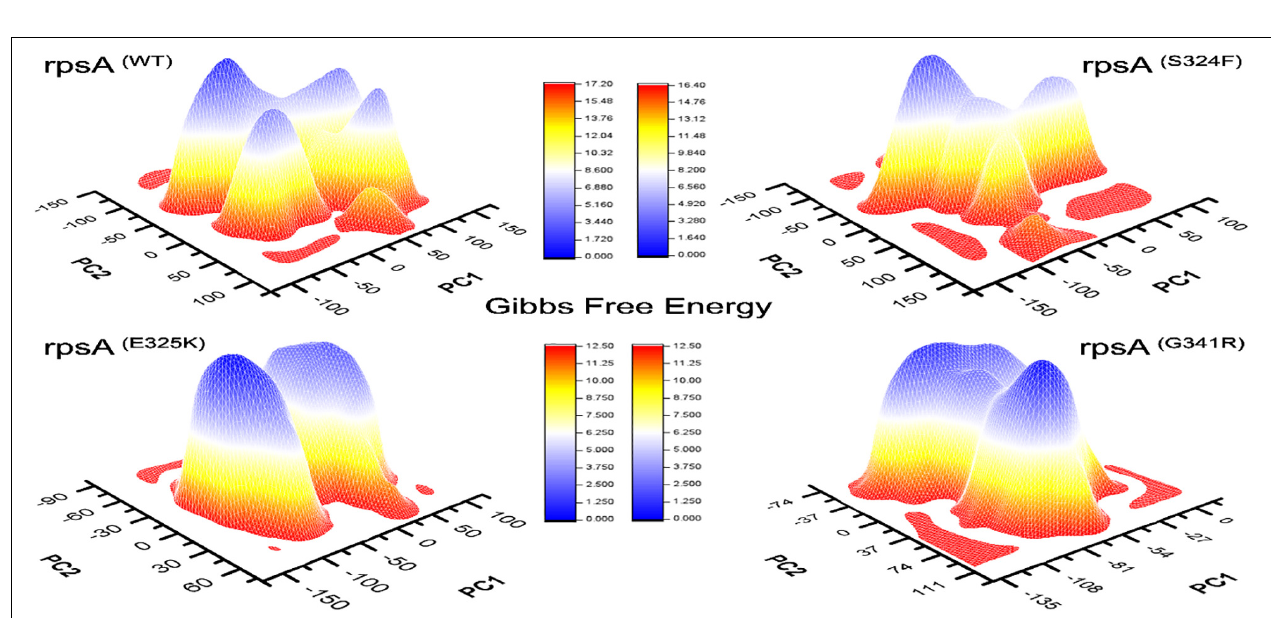
FIGURE 3 | Gibbs free energy (GFE) of WT and MTS, D342N, D343N, A344P, and I351F in apo and complex states. Wild type has a significant GFE difference to MTs as indicated by the color of the GFE plot. WT exhibited a more stable state as compared to mutants. POA resistance might be due the GFE states altering the affinity of RpsA (Khan et al., 2019b).